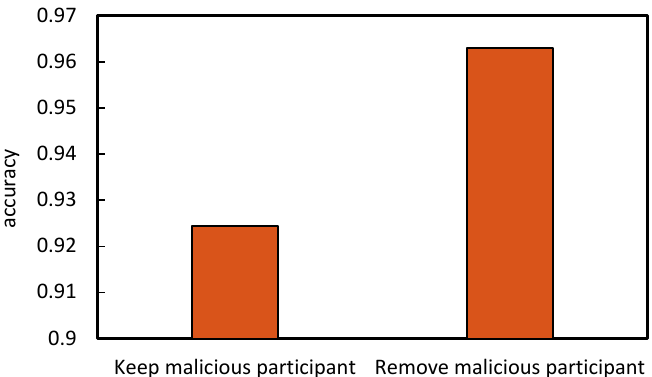
Figure 12. Comparison before and after removing the malicious